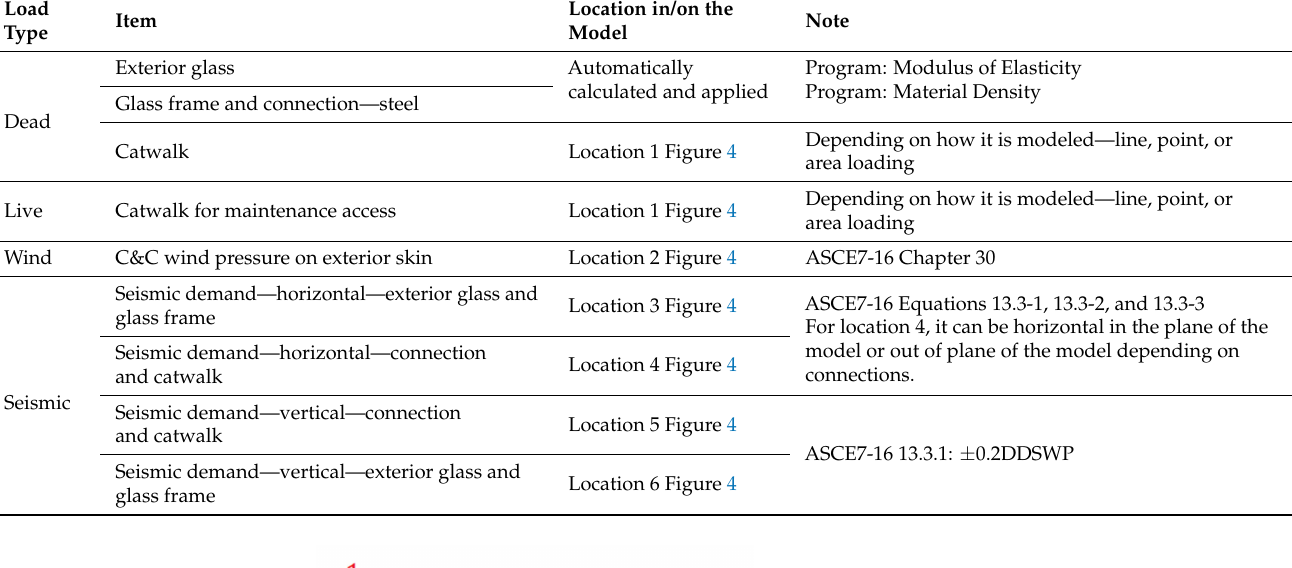
Table 13. Loading Model Parameters for Structural Modeling.